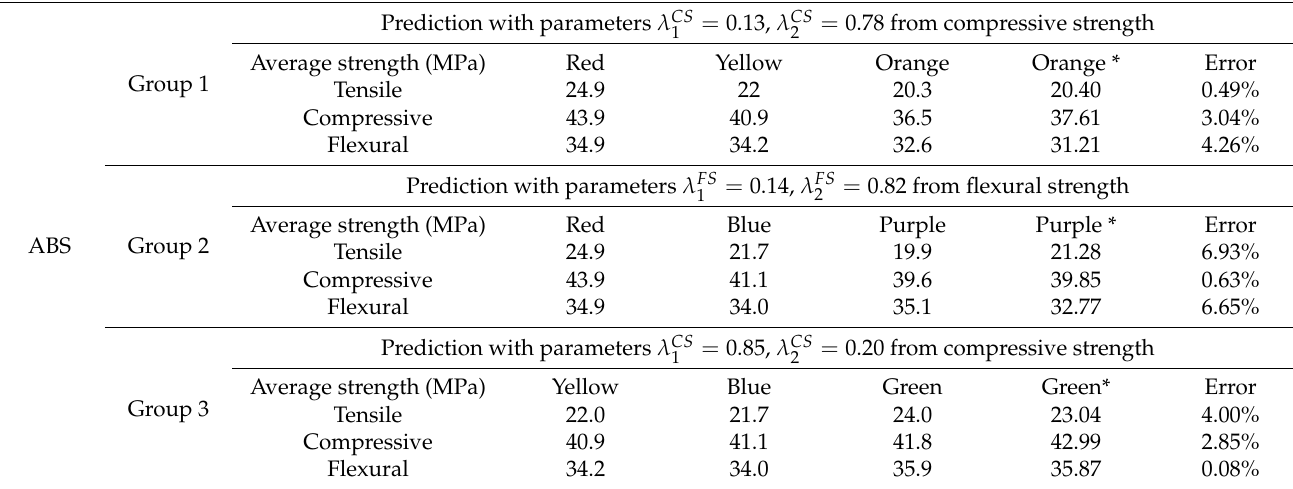
Table 6. Predicated values for mechanical strengths of ABS with two-mixed colors.